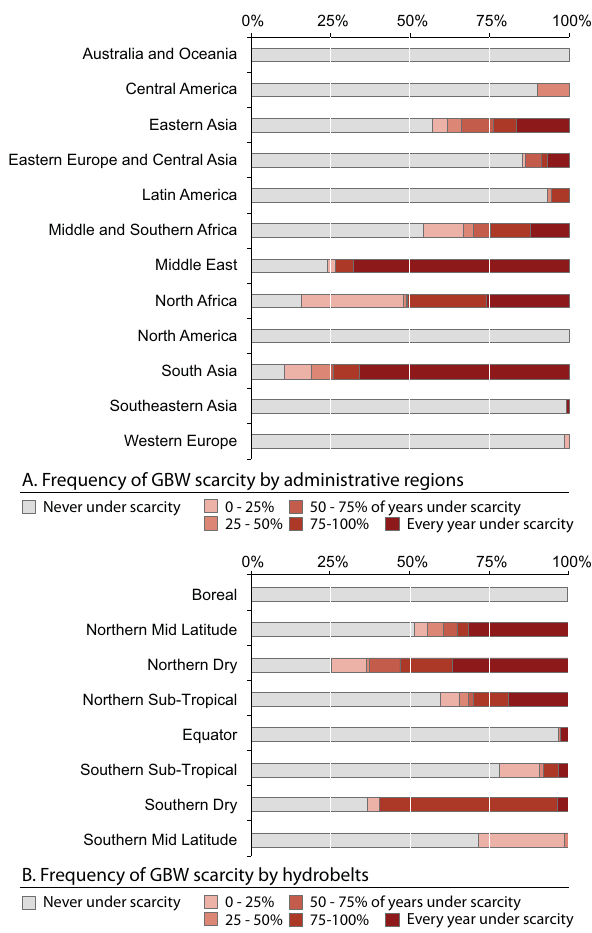
Fig. 3. Frequency of green-blue water (GBW) scarcity aggregated by (A) administrative regions, and (B) hydrobelts. See maps of the administrative regions and hydrobelts in Supplementary (Fig. S1A and S1B in the Supplement,